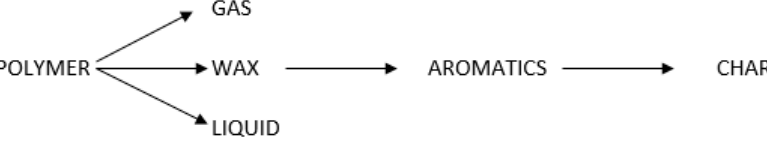
Figure 2. Expected end-products from pyrolysis [22].